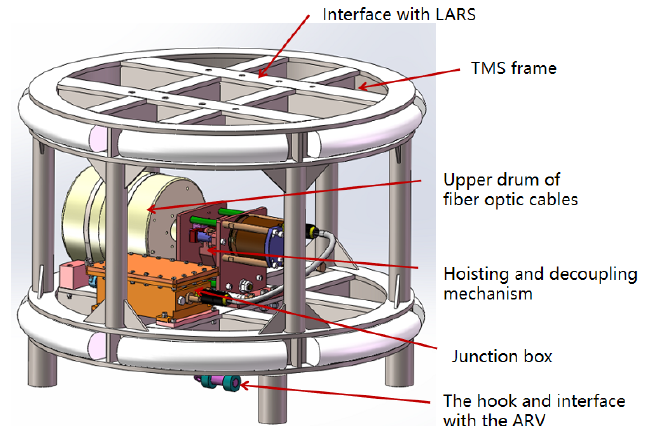
Figure 16. The general arrangement of the TMS.